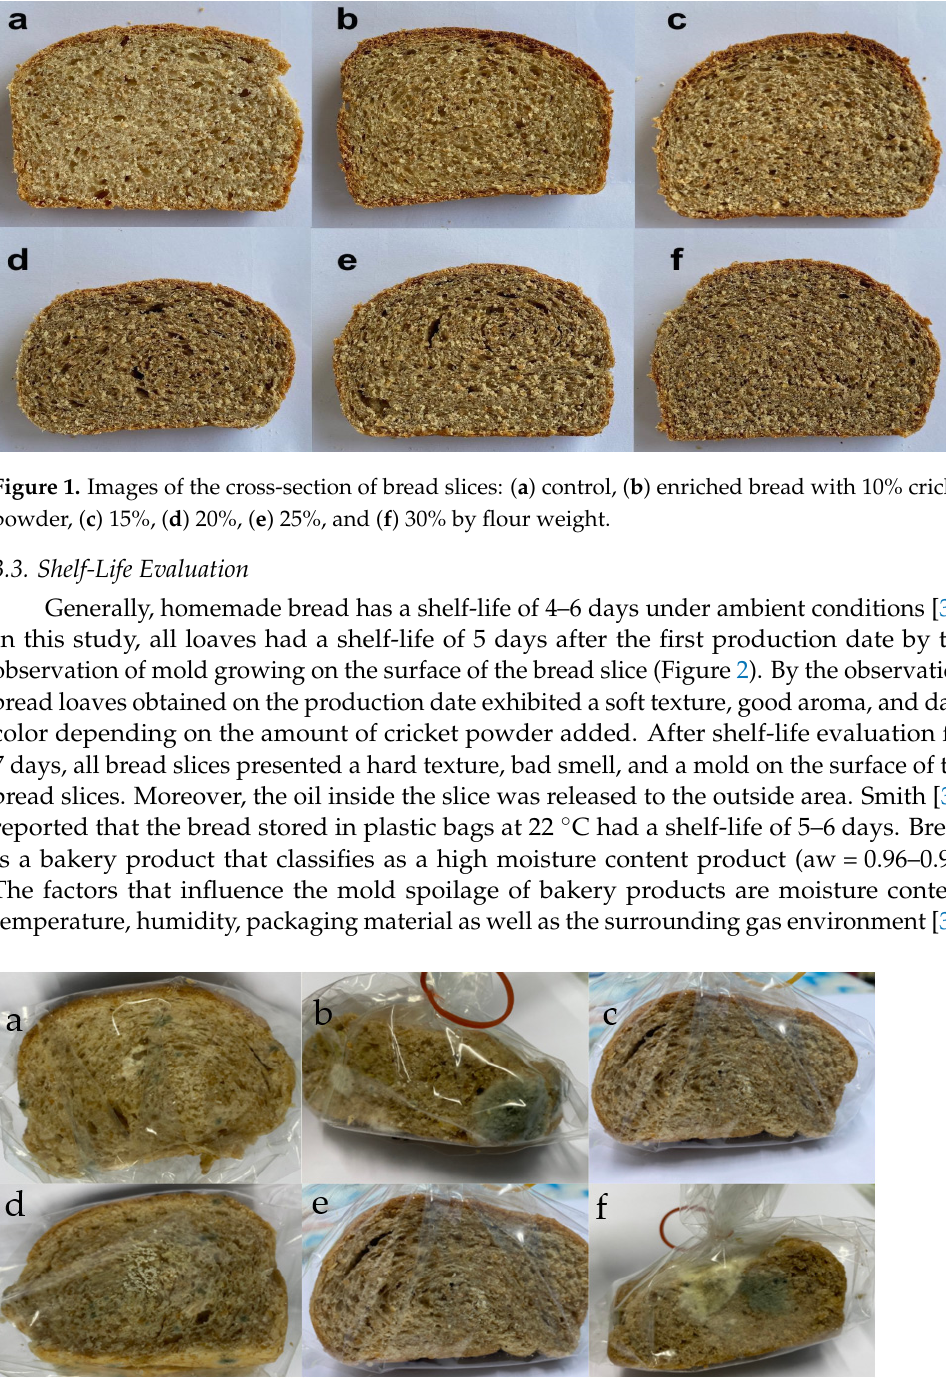
Figure 2. The mold growth on the cross-section of bread slices during shelf-life evaluation on the 5th day of storage at ambient temperature. ( a ) control, ( b ) enriched bread with 10% cricket powder, ( c ) 15%, ( d ) 20%, ( e ) 25%, and ( f ) 30% by flour weight.